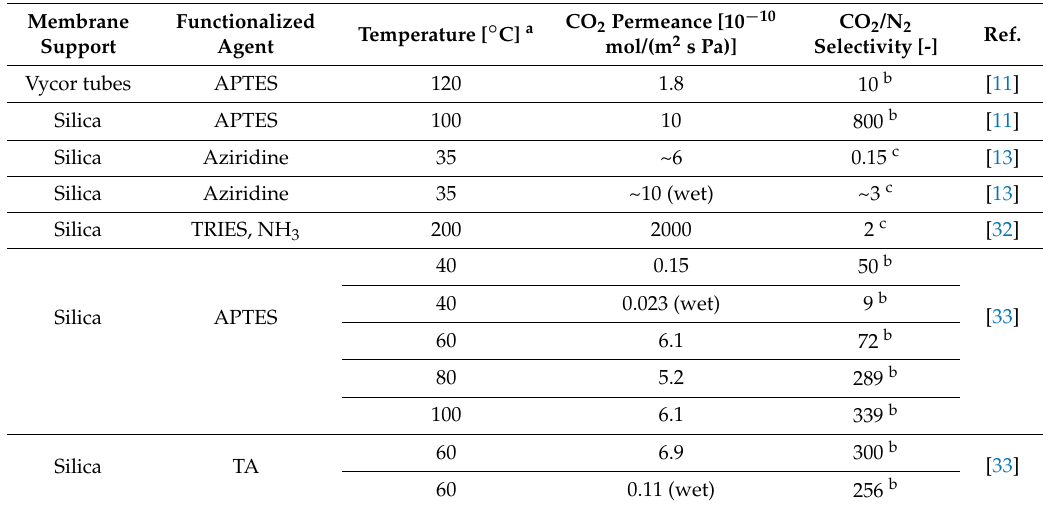
Table 2. Summary of synthesis conditions and membrane performance for reported amine-functionalized silica-based membranes fabricated via post-treatment of mesoporous silica-based membranes. Membrane